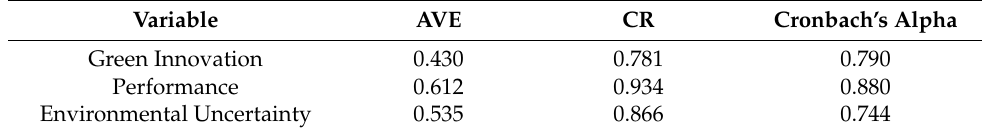
Table 4. Validity and